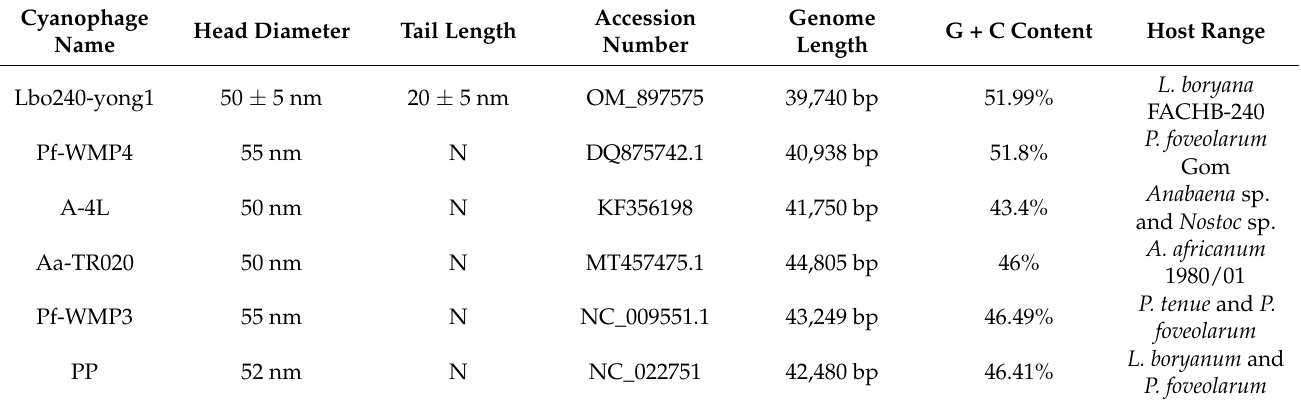
Table 3. Comparison of basic characteristics of the six relative freshwater cyanopodoviruses.